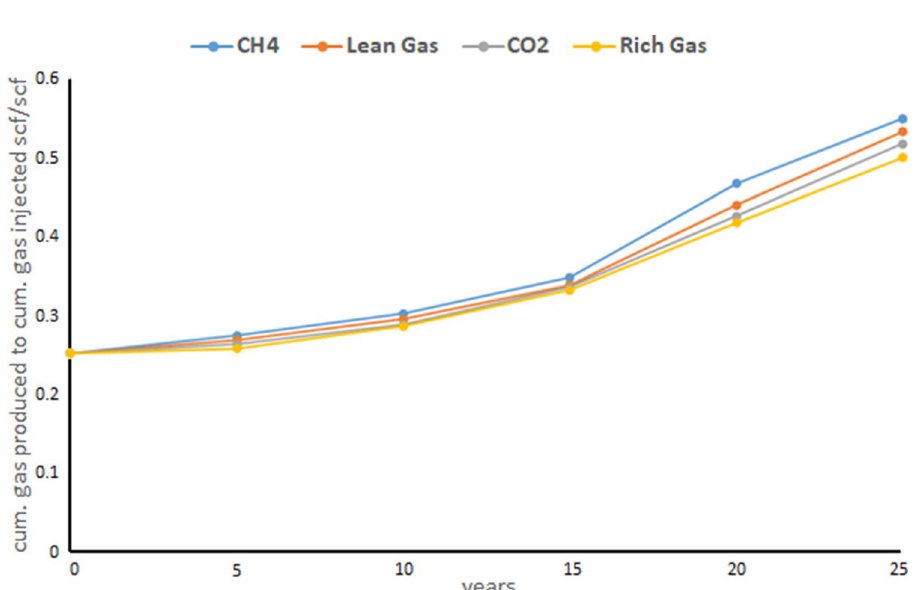
Fig. 6 Cumulative gas produc- tion to cumulative injection gas ratio in different gas injec- tion